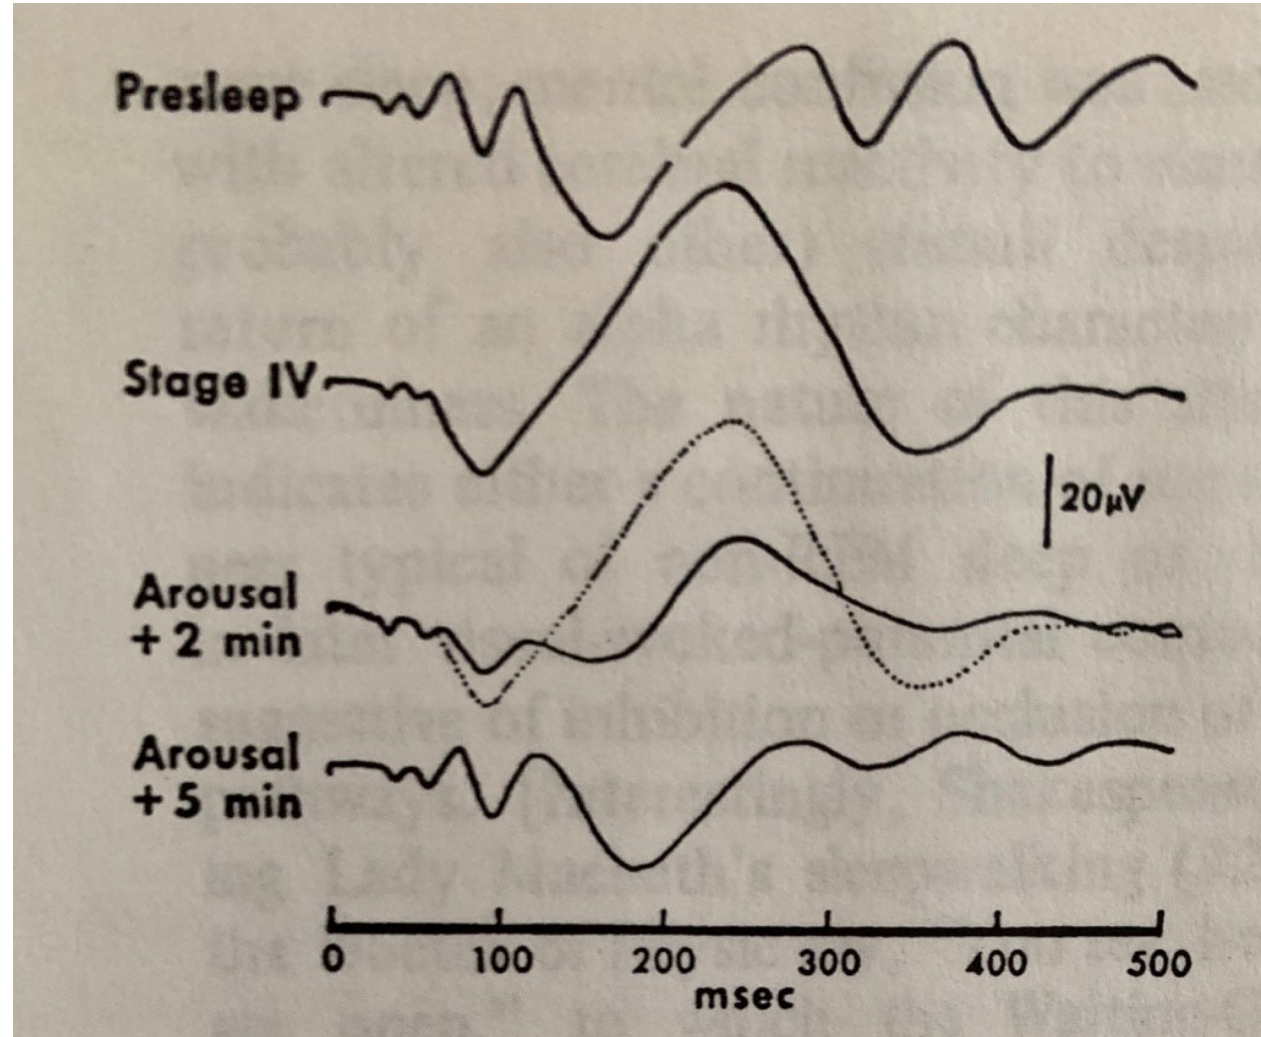
Figure 12. Visual evoked potentials (VEPs) in a healthy young adult in pre-sleep wakefulness, in deep stage 4 slow-wave sleep and 2 min and 5 min after a forced awakening associated with confusional arousals. Positivity at the active electrode is down. In the pre-sleep potential note the large positivity at about 190 msec latency followed by the summation of rhythmic alpha rhythm. In stage 4 there is a large three component response with a positivity at around 100 msec, a huge negativity at about 250 msec and a positivity at about 360 msec. This is essentially an averaged K-complex. Two minutes after the forced confusional arousal the VEP shows features of both slow-wave sleep and wakefulness. Five minutes after arousal the VEP is very similar to that of presleep wakefulness but of somewhat lower amplitude and with slightly longer latencies. (Reproduced with